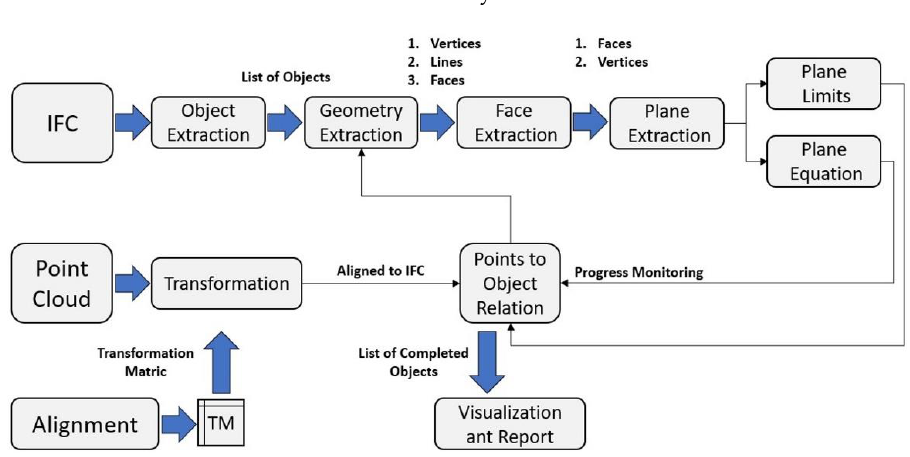
Figure 6. Progress monitoring pipeline.